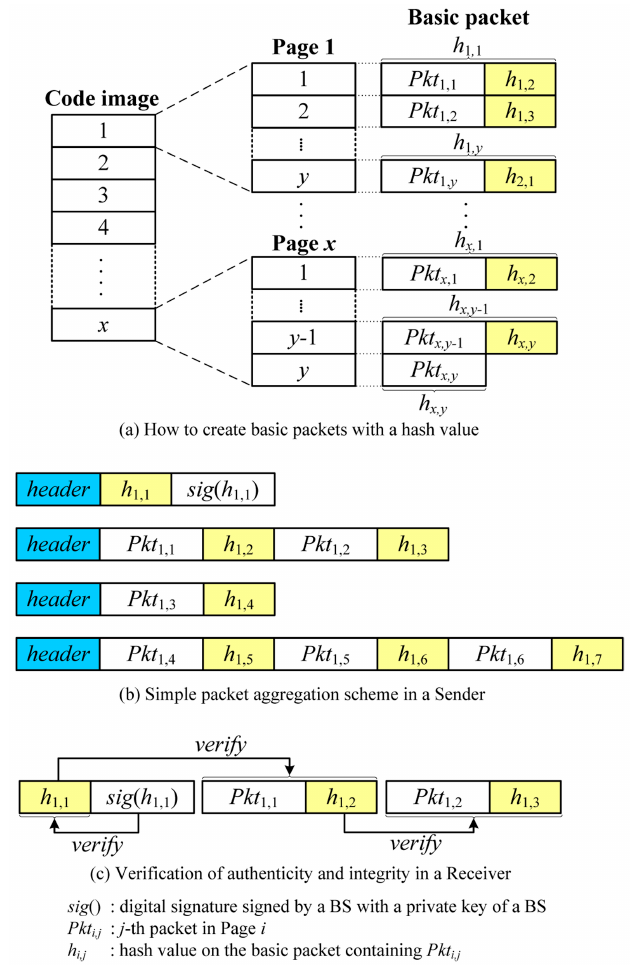
Figure 5. An example of SPA.